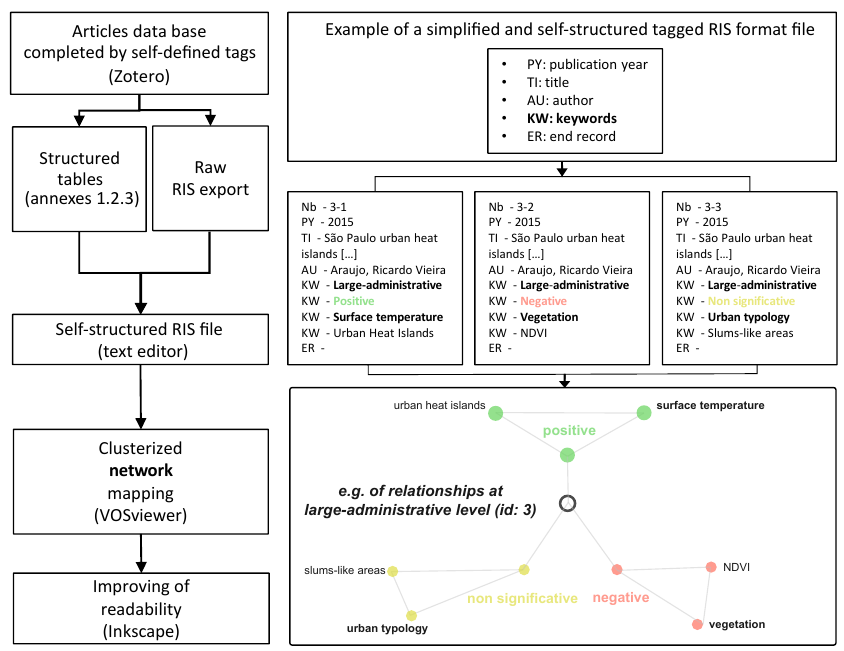
Figure 2. Method used to map the co-occurrence relationship between the self-defined tags, here keywords, for each of the articles. Keywords are specific self-defined tags, which may here refer to: landscape factors (e.g., “Urban Heat Island”), structuring terms (in bold, e.g., “Urban typology” or “large administrative-level”), or nature of the relationship (in color, e.g., “positive”). We added a tag, called Nb (number), which helps to identify the id number of the included article (here 3 of [n =